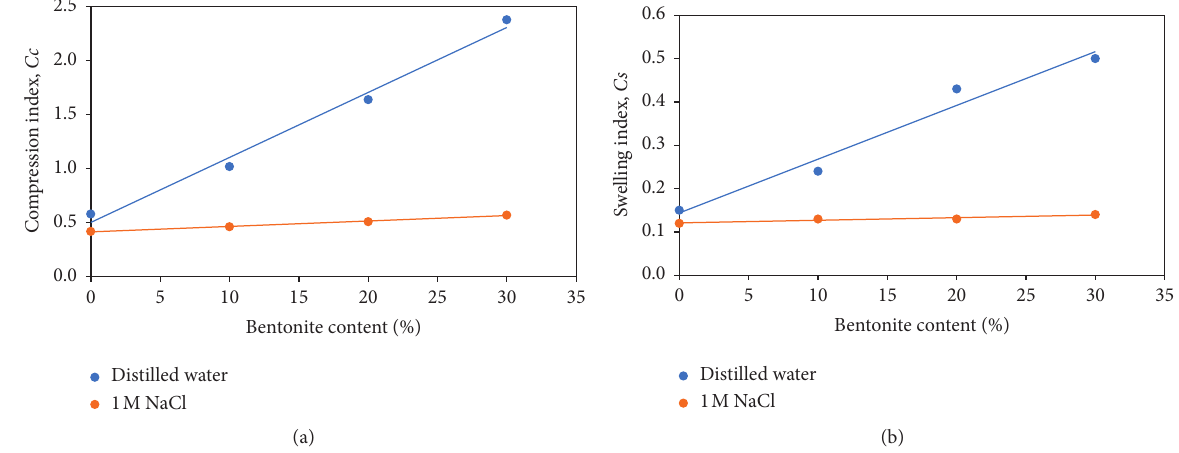
Figure 3: Influence of bentonite content on the compression and swelling indices.